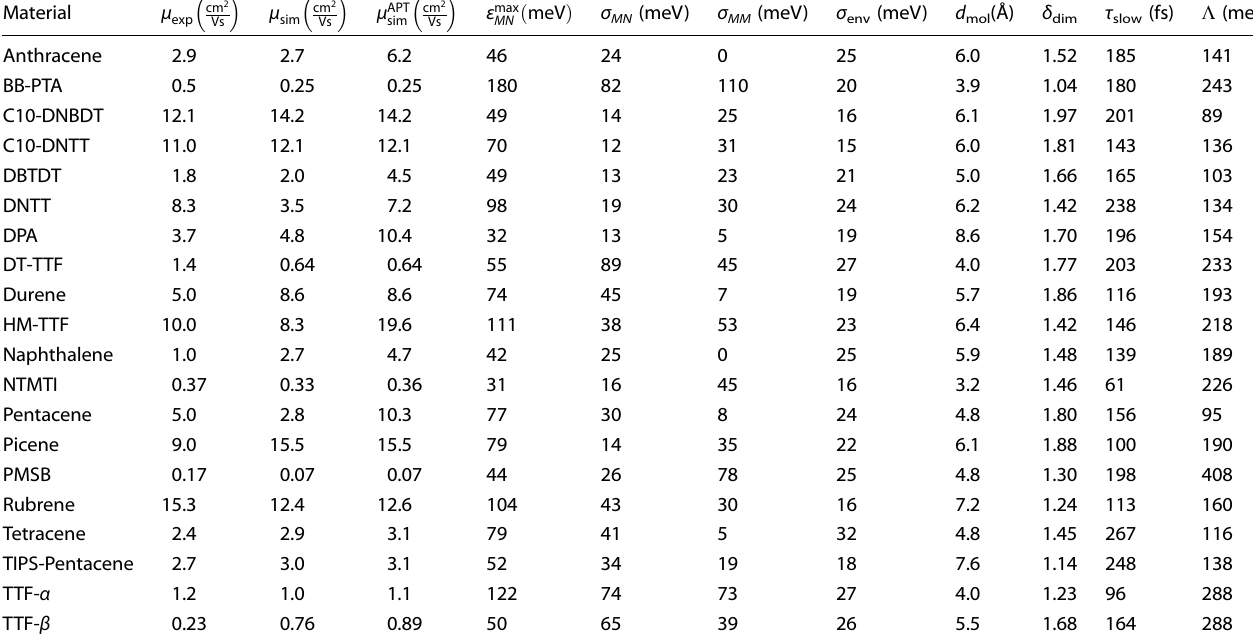
Table 1. Analyzed materials and their properties.